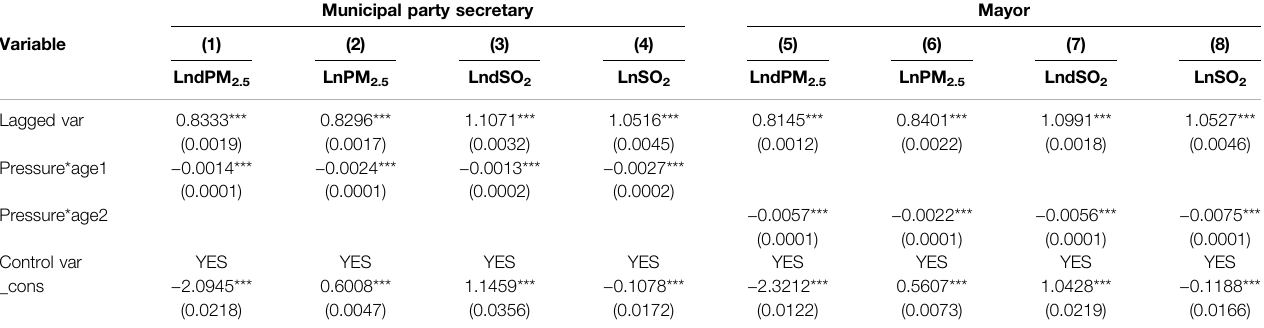
TABLE 6 | The role of age of of fi cials in the environmental effects of fi nancial